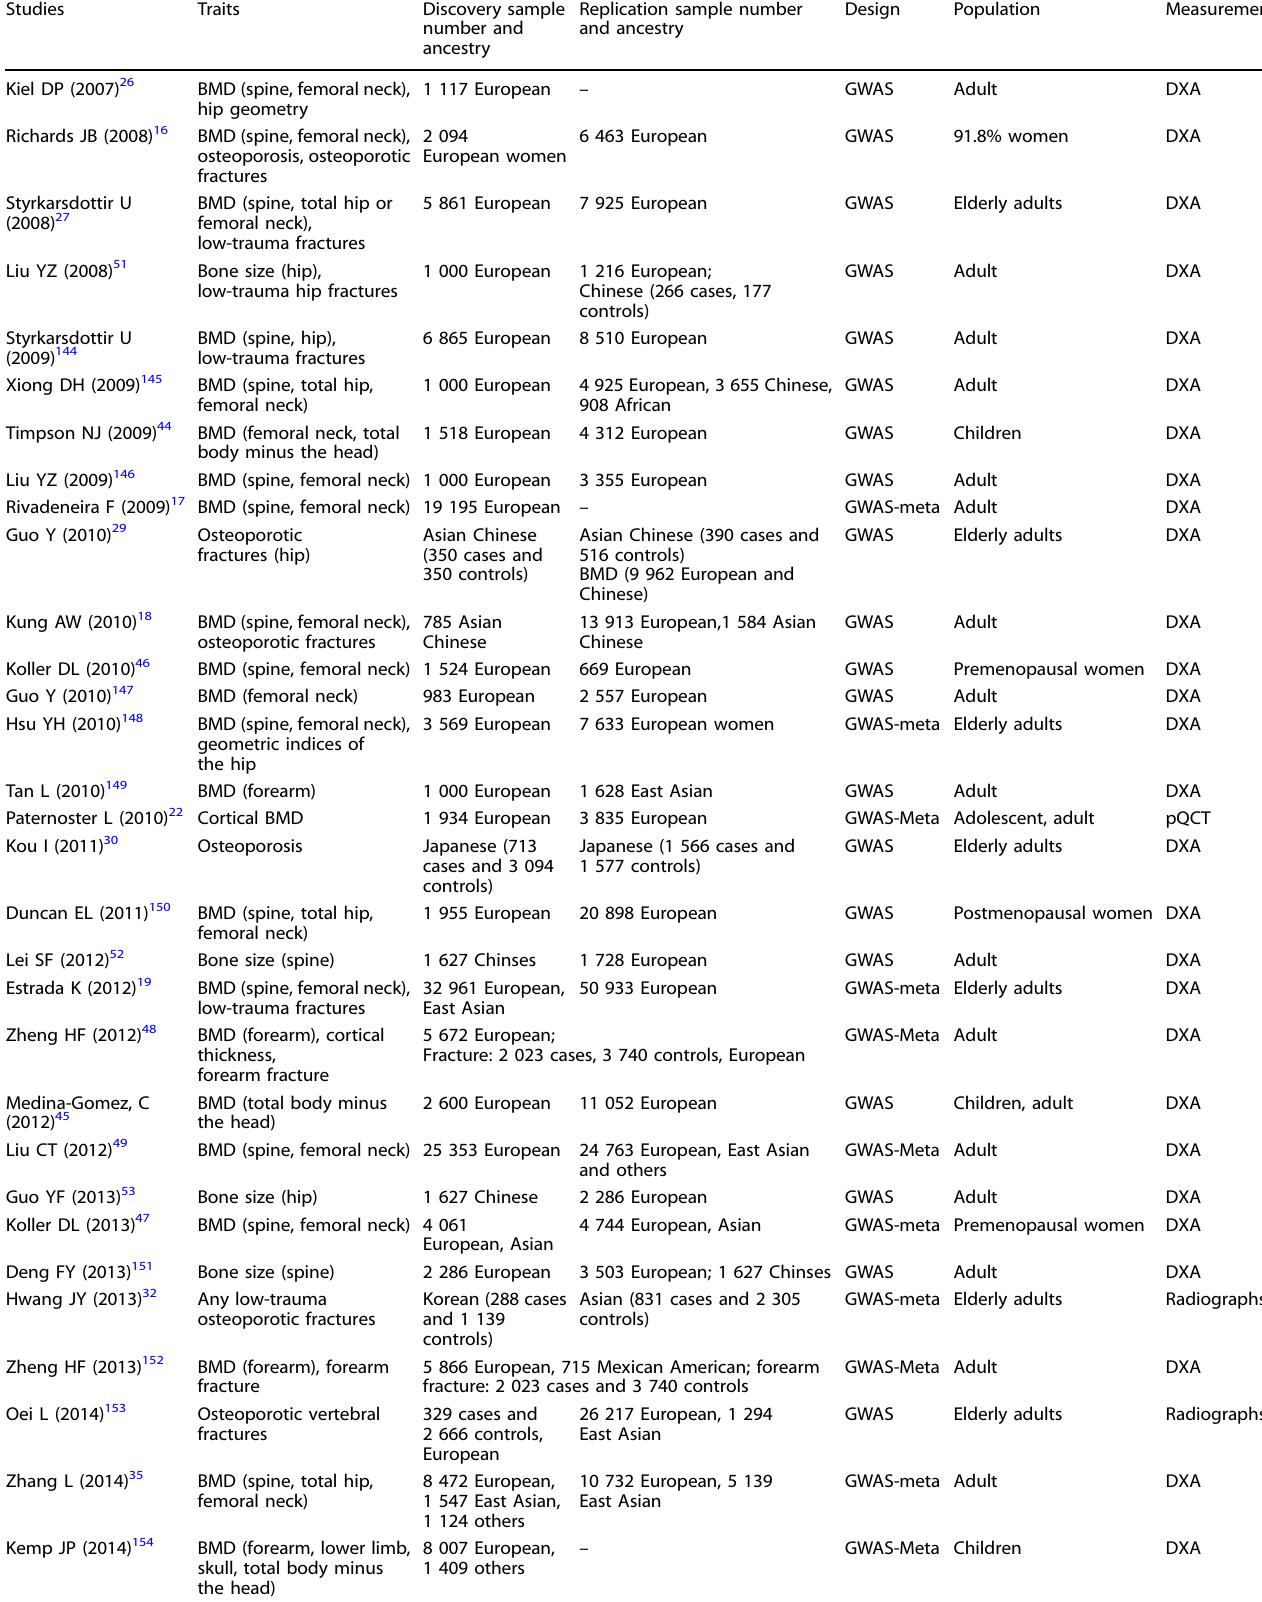
Table 1. Genome-wide association studies conducted on osteoporosis and related traits